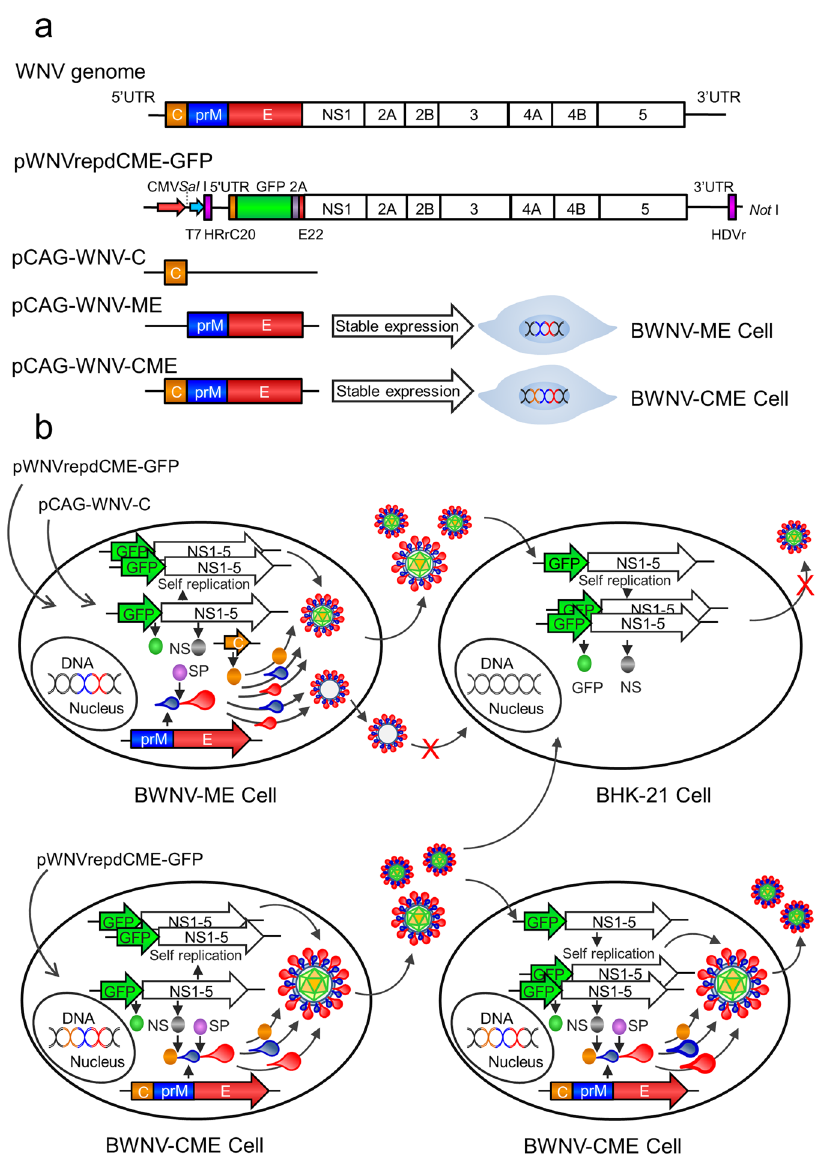
Figure 1. Schematic representation of WNV replicon constructs and packaging of WNV reporter replicon particles (RRPs). ( a ) The DNA based WNV replicon is under control of the CMV promoter. The replicon genome lacks the major coding sequence of the structural protein, C-prM-E, and the corresponding sequence was replaced with a GFP coding sequence following the FMDV 2A coding sequence. The replicon RNA with an authentic 5 ′ terminus is ensured by placing a hammerhead ribozyme sequence (HRr) before the first 5 ′ UTR nucleotide. The authentic 3 ′ terminus is ensured by the addition of a hepatitis delta virus ribozyme sequence (HDVr) after the last 3 ′ UTR nucleotide. To complement the structural proteins, a capsid protein expressing plasmid was constructed. The BWNV-ME cell line stably expressing the prM-E protein was generated via transfecting BHK-21 cells with the pCAG-WNV-ME plasmid. The BWNV-CME cell line stably expressing the C-prM-E protein was generated by transfecting BHK-21 cells with the pCAG-WNV-CME plasmid. ( b ) WNV RRPs are packaged in two ways. First, the pCAG-WNV-C and replicon plasmids were transfected into BWNV-ME cells. The pCAG-WNV-C plasmid expressed protein C. The cell itself expressed prM and E protein. The replicon plasmid was transcribed by the CMV promoter into the replicon RNA expressing GFP and the non-structural replicase protein. The replicon RNA amplifies itself once again and three structural proteins package the replicon RNA into WNV RRPs which are secreted into the culture medium. The second way is to transfect BWNV-CME cells with only the replicon plasmid. The BWNV-CME cells express the C-prM-E polyprotein which is cleaved into the C, prM and E proteins by replicon RNA-encoded non-structural protease and endogenous cellular signal peptidase (SP). Then three structural proteins package the replicon RNA into RRPs which is secreted into the culture medium. When RRPs infect BHK-21 cells, the replicon RNA expresses GFP and non-structural proteins which amplify more RNA. However, no WNV structural proteins or additional RRPs produced in RRP-infected cells, thereby preventing further spread. When BWNV-CME cells are infected with RRPs, the structural proteins expressed by the cells package the replicon RNA into progeny RRPs and the infection spreads in rounds similar to the wild type